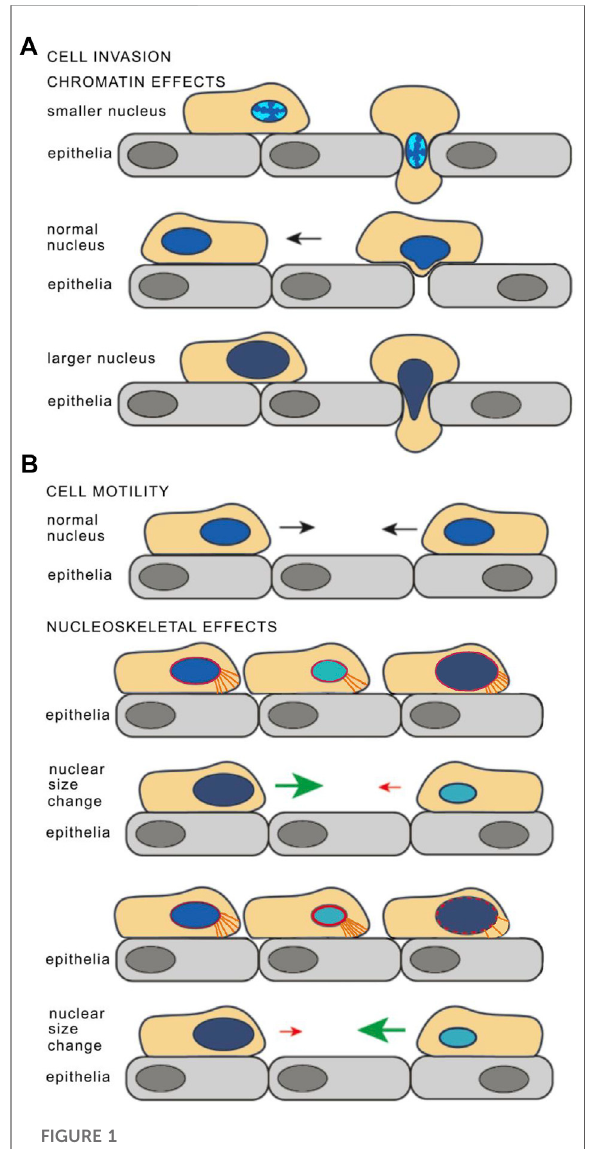
FIGURE 1 Model for how nuclear size changes may affect cancer